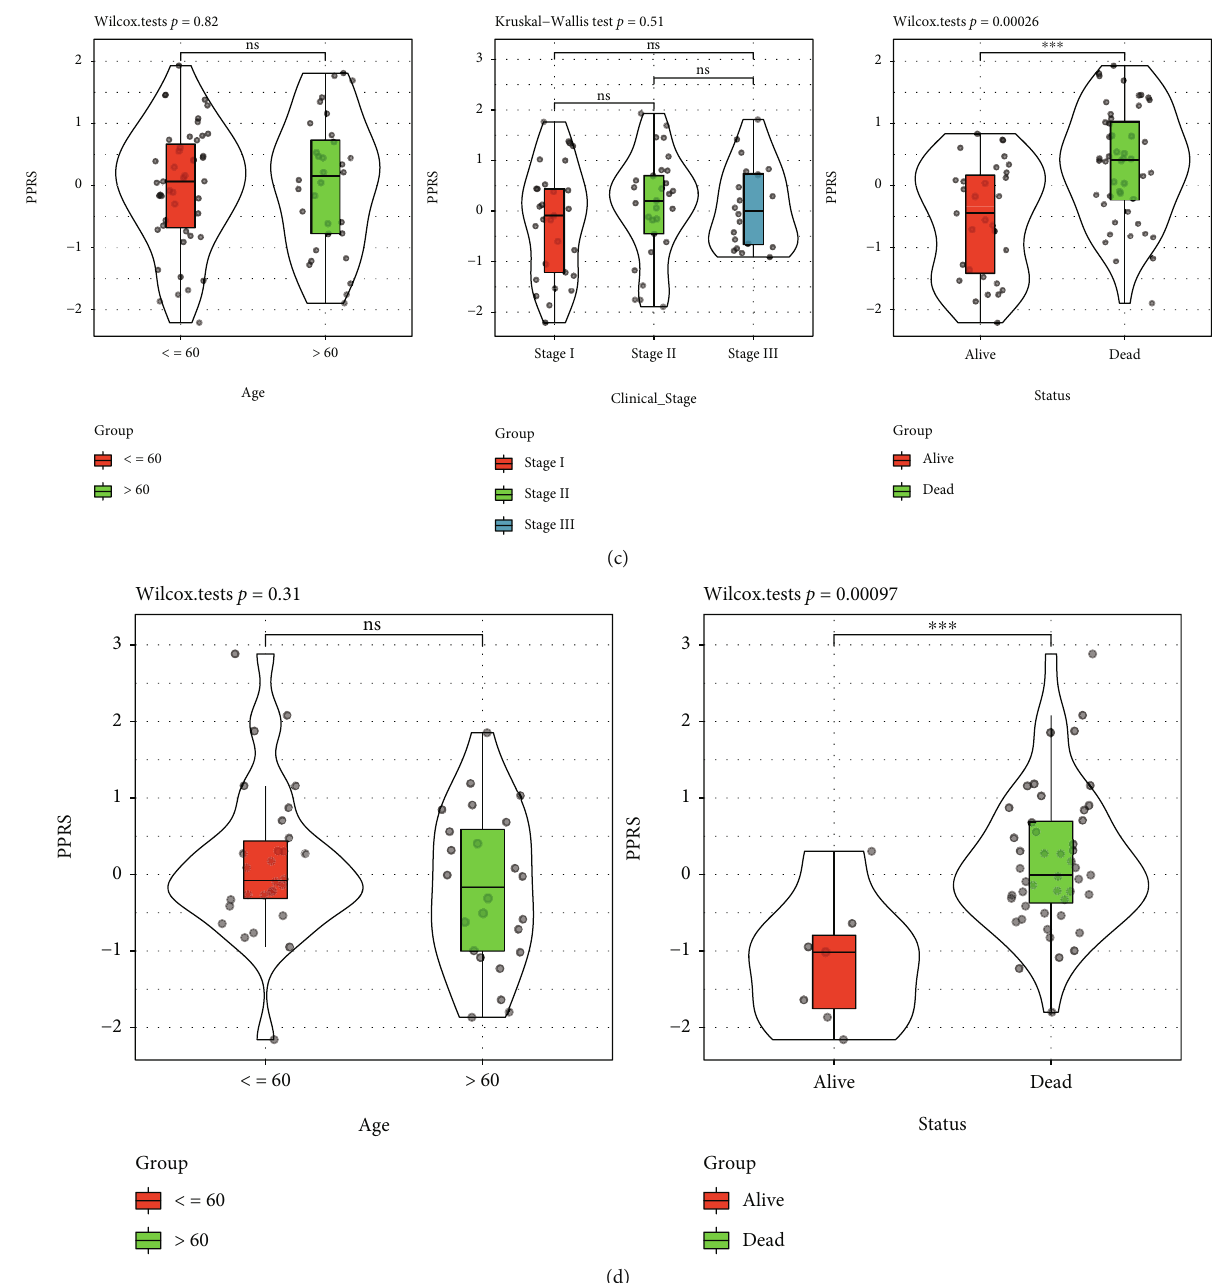
Figure 6: The distribution of PPRS levels in samples with di ff erent clinicopathological features from TCGA-SKCM (a), GSE65904 (b), GSE54467 (c), and GSE22153 (d)